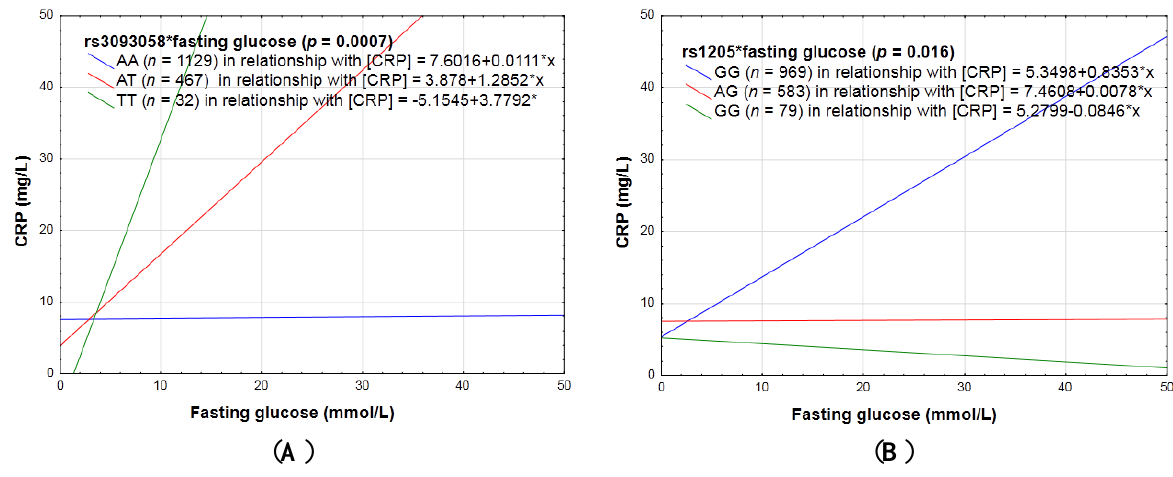
Figure 4. Examples portraying the linear relationship between fasting glucose in relation to CRP concentrations categorized for CRP SNPs with ( A ) a pro- ( B ) or anti-inflammatory effect with the addition of the polymorphic